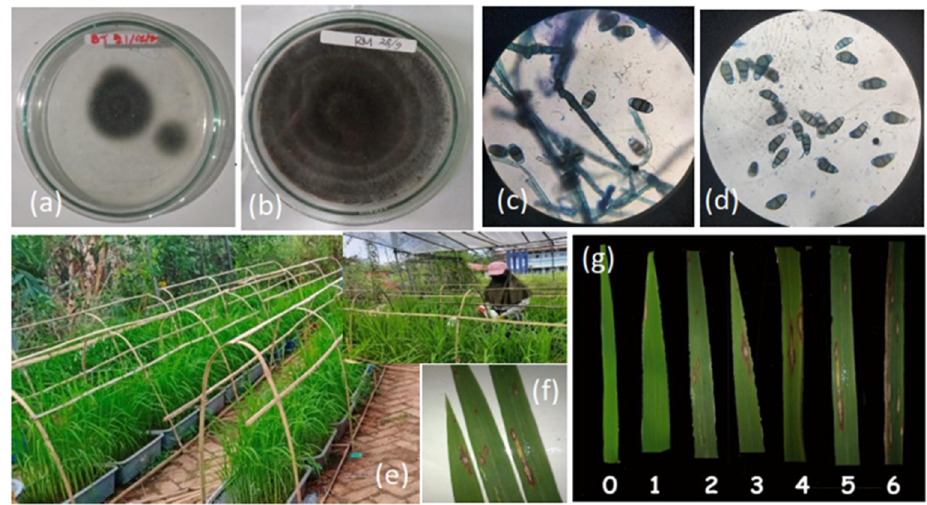
Figure 1. Screening for blast disease resistance of selected rice lines under greenhouse conditions: ( a ) growth of isolate in Petri dish after purification; ( b ) pure culture of blast; ( c ) microscopic identification of P. oryzae at 100 × magnification; ( d ) isolation of monoconidia or single conidia using a needle mounted on a microscope; ( e ) greenhouse experiment; ( f ) the blast lesion lengths of susceptible line; ( g ) blast lesion scale on rice leaves, ranging from 1 to 6 base on SES IRRI modified (0: no symptom; 1: spots in the form of needle of several mm but not yet elliptical; 2–3: Elliptical shaped spots, infected leaf surface area reaches 2%; 4–5: Infected leaf surface area reaches > 2 ≤ 10%); 6–7: Infected leaf surface area reaches >10 ≤ 50%) (Table S2).